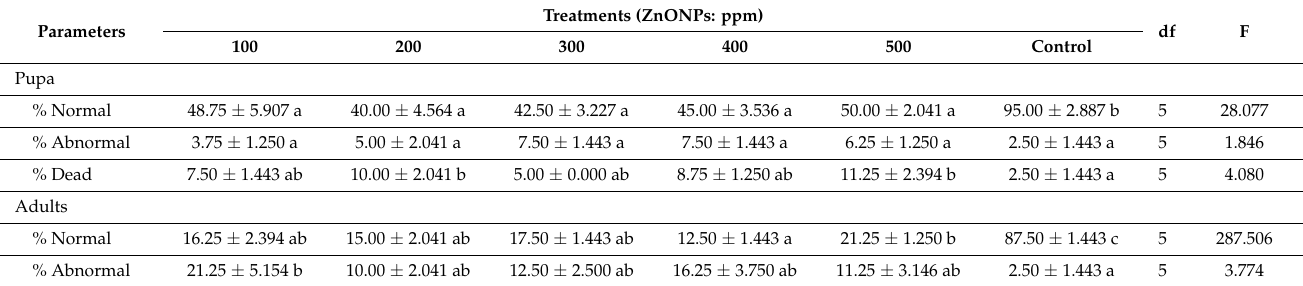
Table 3. Mean ( ± SE) percentages of pupa and adult normal/abnormal/dead of FAW fed on food (baby-corn) dipped in ZnO NPs different concentrations (100–500 ppm).